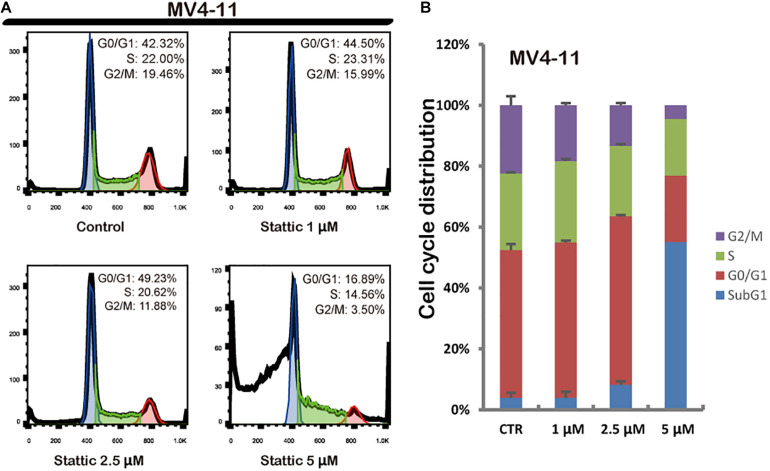
Stattic blocks the cell cycle in the G0/G1 phase. Cells were treated with 0, 1, 2.5, and 5 μM Stattic for 24 h. All cell cycle analyses were conducted thrice. The cell cycle distribution was determined using propidium iodide staining (A,B).